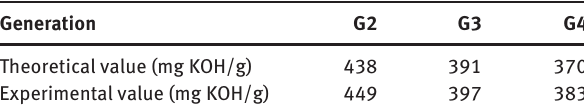
Table 3 Hydroxy value of HPAE.